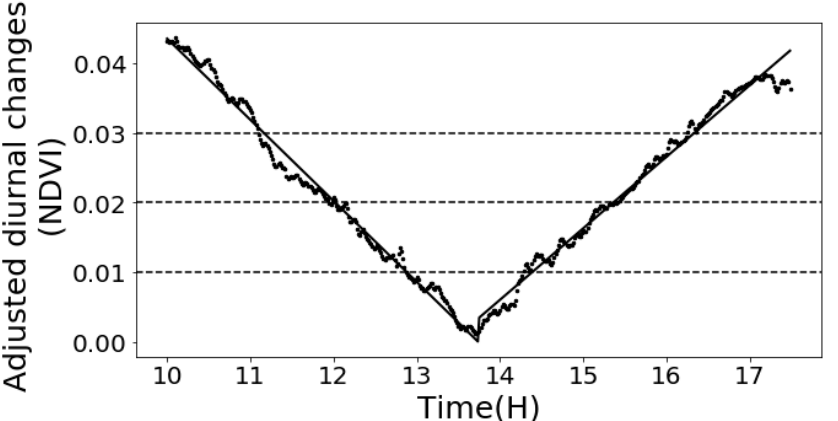
Figure 9. The intersections between the adjusted NDVI’s diurnal changes and three different thresh- olds for proper imaging windows. The x-axis is the diurnal time in a unit of hour. The y-axis is the adjusted NDVI’s diurnal changes when adjustment at solar noon to be 0. Table 7. Proper imaging windows for different thresholds of the NDVI changes caused by diurnal factors (when solar noon is the standard imaging time).